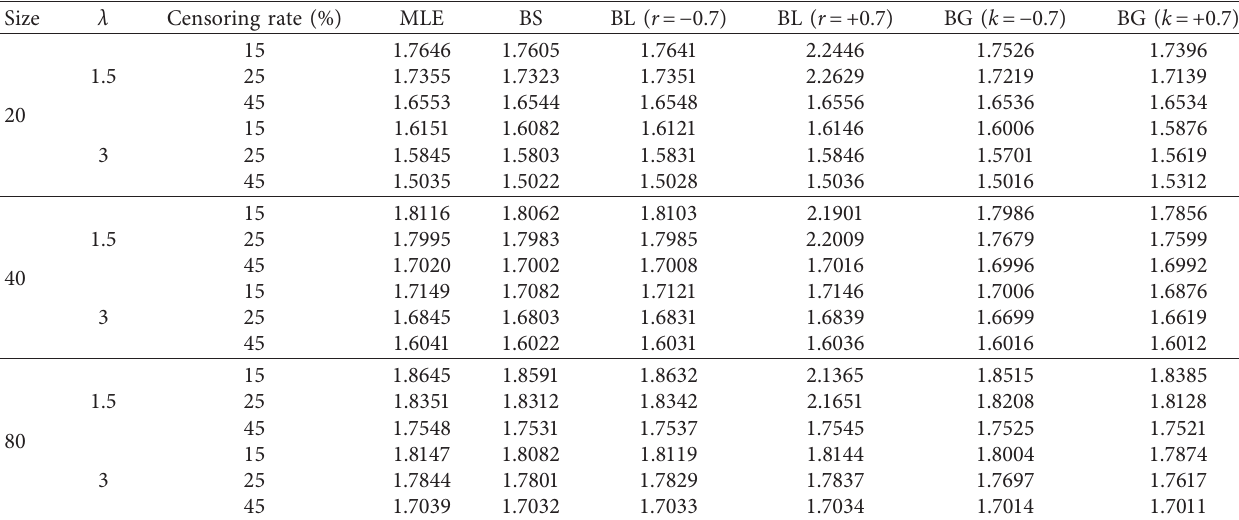
Table 4: Estimations of θ with a cure fraction based on the interval-censored